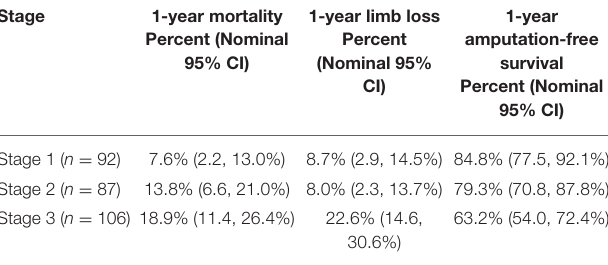
TABLE 3 | Outcomes by stage.